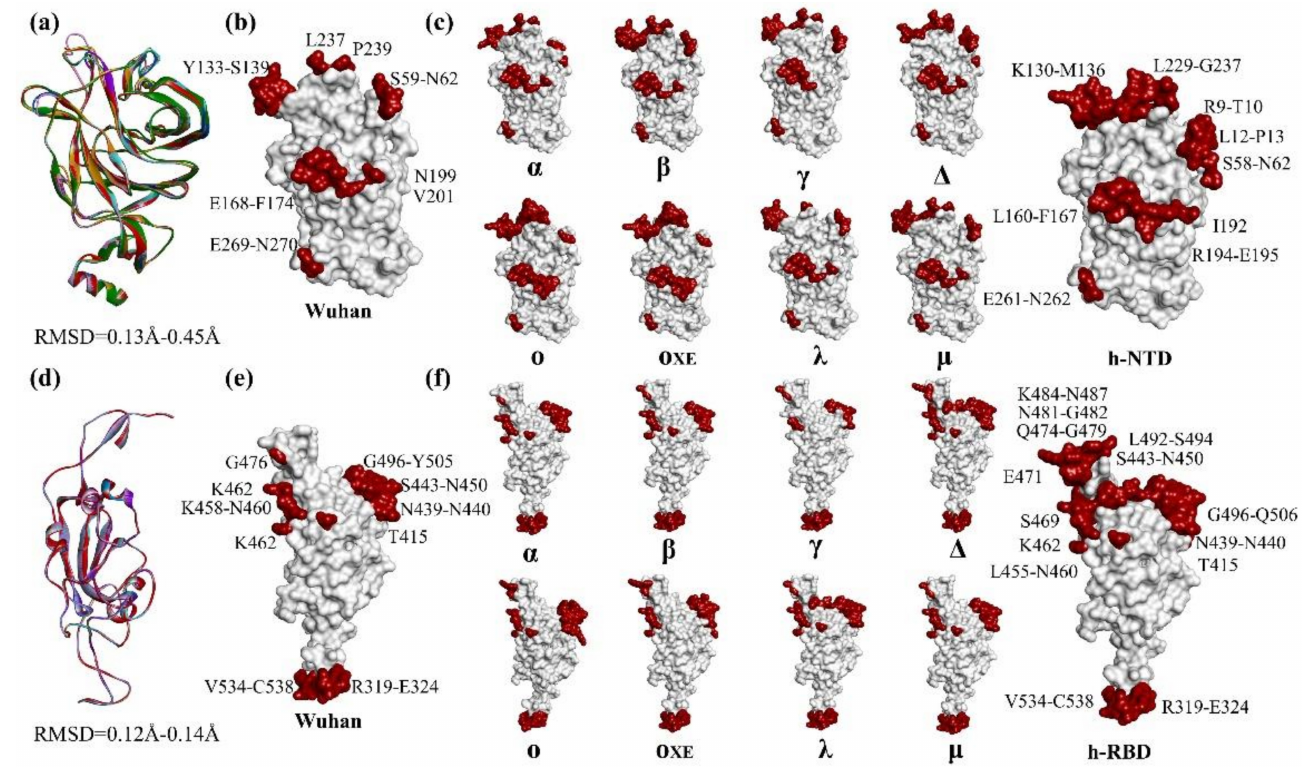
Figure 3. Structure and epitopes of NTDs and RBDs. ( a ) Ribbon diagram of superimposed NTD of different SARS-CoV-2 variants including h-NTD showing structural variations. Distribution of epitope (maroon) in the surface topology of NTD of ( b ) SARS-CoV-2/Wuhan and ( c ) different SARS- CoV-2 VOCs, VOI, and h-NTD as labeled. ( d ) Ribbon diagram of superimposed RBD of different SARS-CoV-2 variants including h-RBD representing structural variations. Distribution of epitope (maroon) in the surface topology of RBD of ( e ) SARS-CoV-2/Wuhan and ( f ) different SARS-CoV-2 VOCs, VOI, and h-RBD as